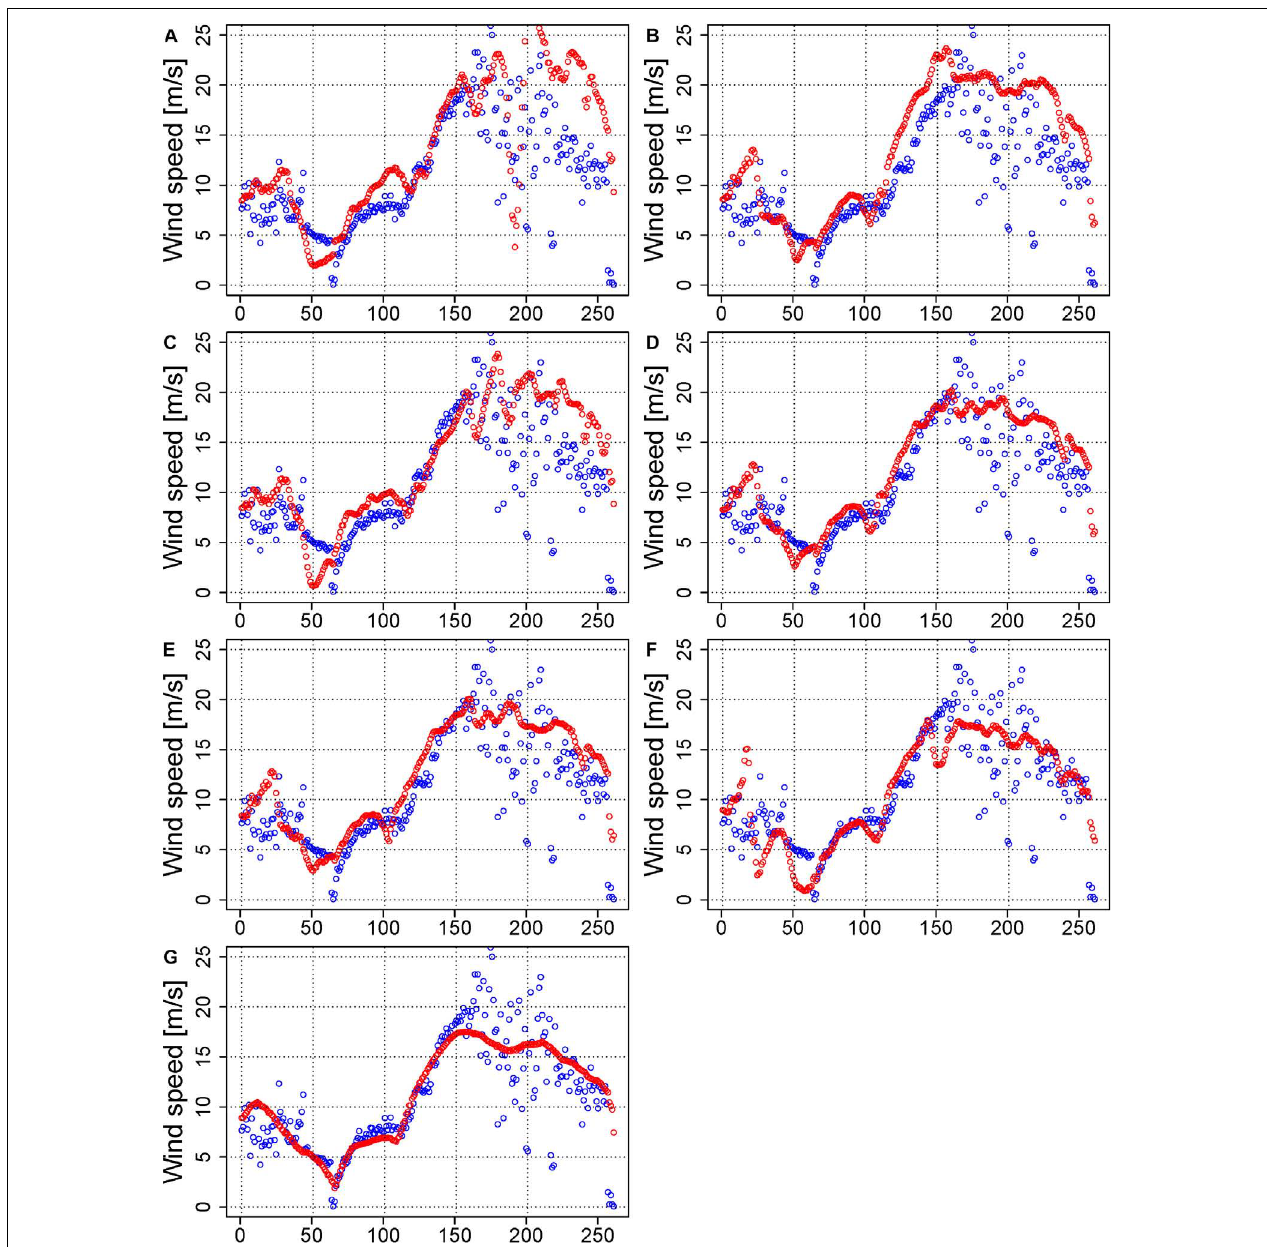
Figure 9 and Supplementary Figure 3 show that ECMWF fits the observed SWH the best, followed by the ERA5 reanalysis dataset. The ERA5 data underestimate observations at several stations, including stations 1, 3, 4, and 6. In general, the downscaling simulations overestimate the observed SWH in the extreme state. Similar to wind, the time of reaching maximum SWH values of the 1w_wind and 2w_new runs is shifted from the observations. The peak of the maximum SWH in the 2w_new_SN and 2w_old_SN